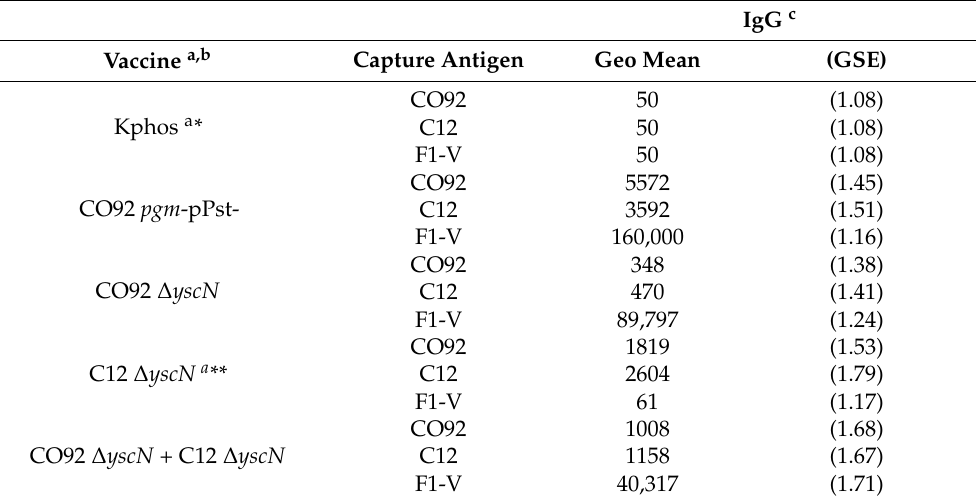
Table 5. Humoral immune responses elicited by one dose of Y. pestis vaccine